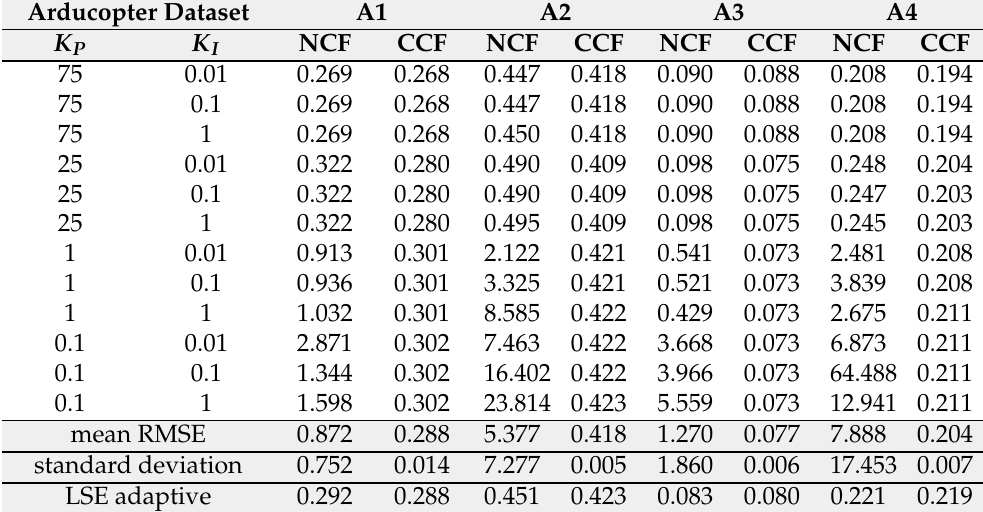
Table 2. Average RMSE (in radian) obtained for NCF and CCF with varying K P and K I (Ar- ducopter datasets).